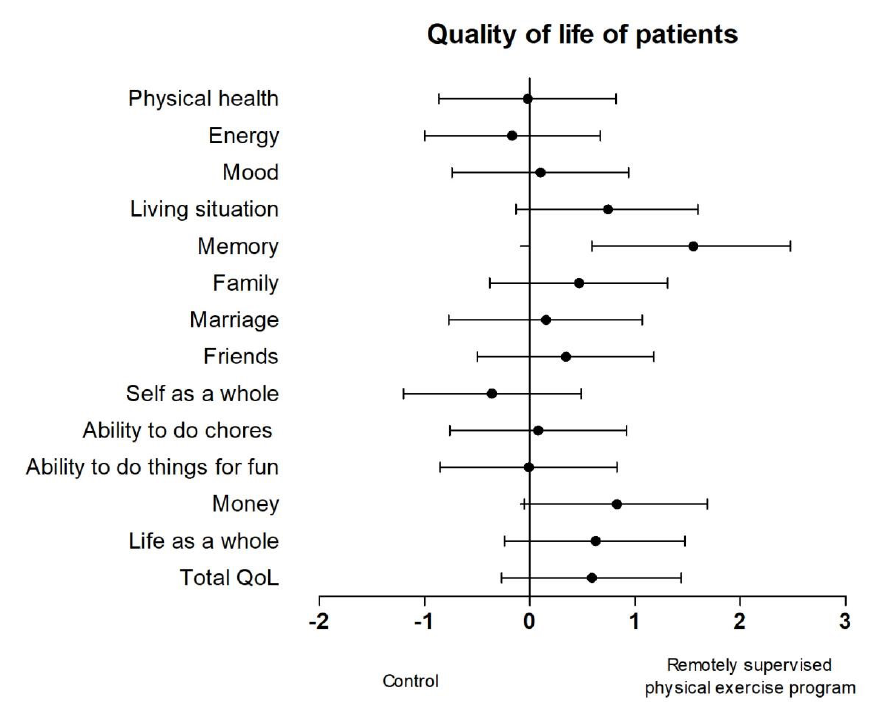
Figure 2. Quality of life effect sizes by